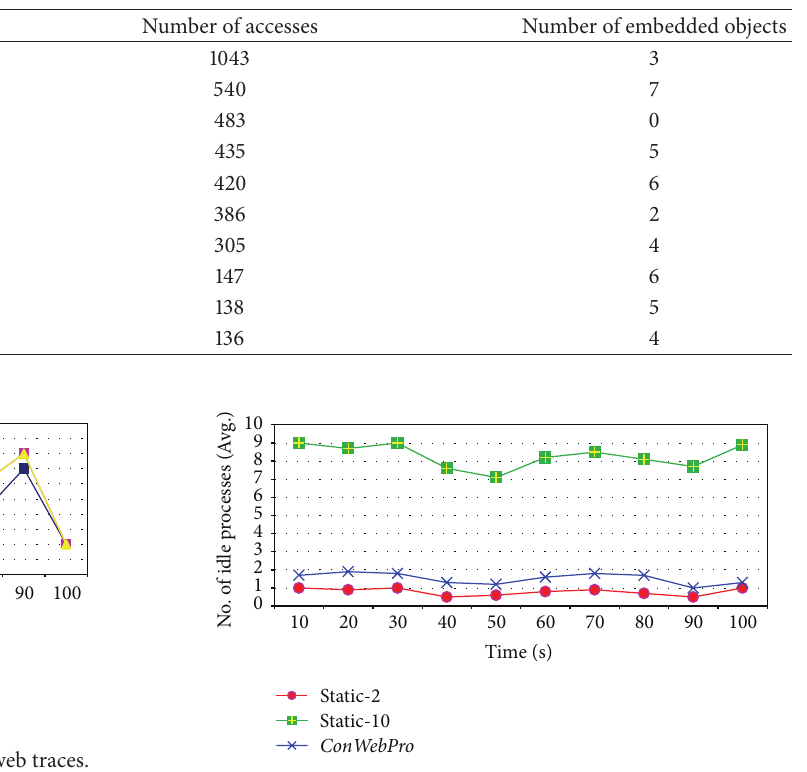
Figure 9: The average idle processes at NASA web traces.